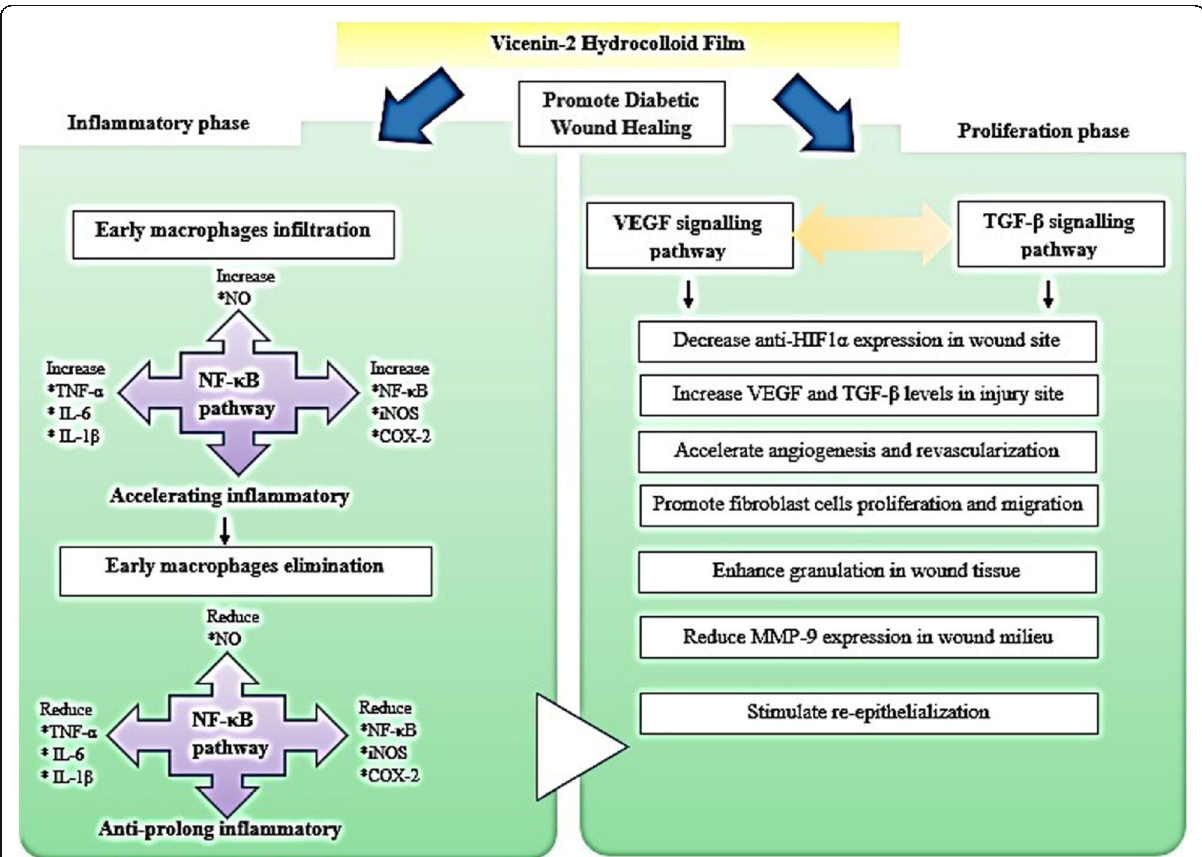
Fig. 7 Mechanism pathways of VCN-2 to enhance excision wound healing in diabetic rats. Abbreviation: Cyclooxygenase2 (COX-2), inducible nitric oxide synthase (iNOS), inhibitor of κ B (I κ B- α ), nitric oxide (NO), nuclear factor-kappa B (NF- κ B), tumor necrosis factor-alpha (TNF- α ), interleukin (IL), metalloproteinase (MMP), hypoxia inducible transcription factor-1 alpha (HIF-1 α ), vascular endothelial growth factor (VEGF) and transforming growth factor beta (TGF- β